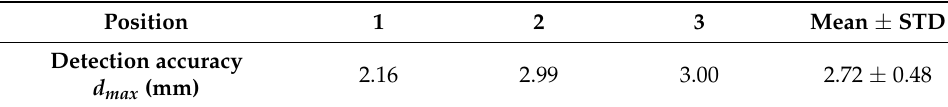
Figure 18. Results of 2D reconstruction for catheter position 1, 2, and 3 in the heterogeneous model. Table 4. Detection accuracy-Optimized heterogeneous model.